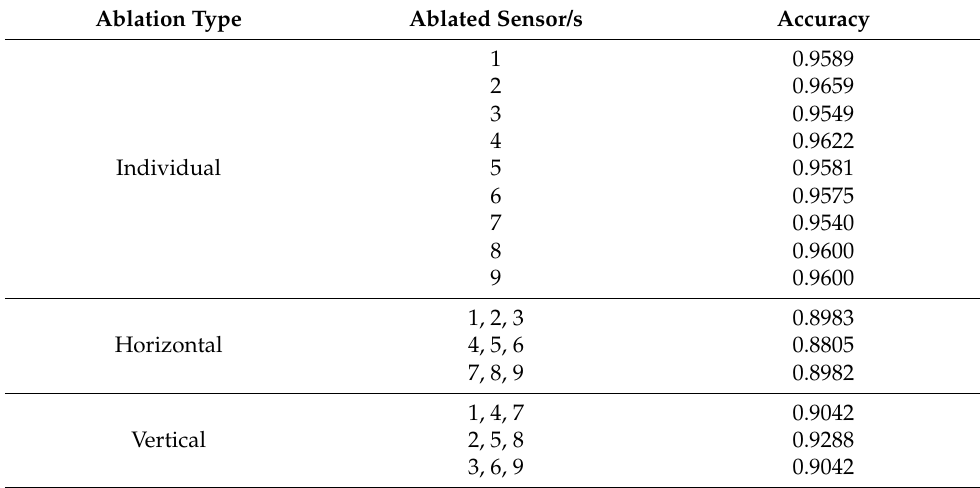
Table 3. Classification performance of random forest classifier in the sitting posture recognition task for different ablation settings.